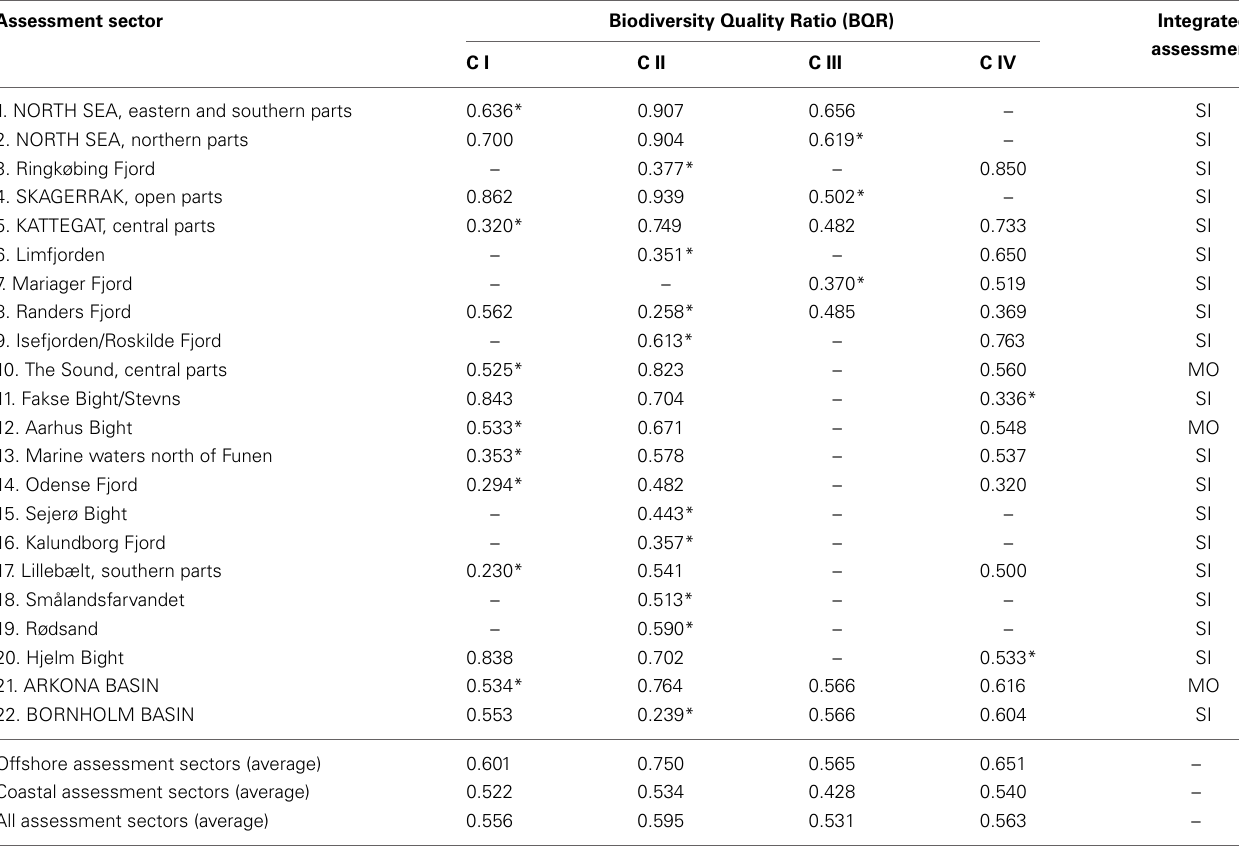
Table 1 | Assessment and classification of biodiversity status in Danish marine